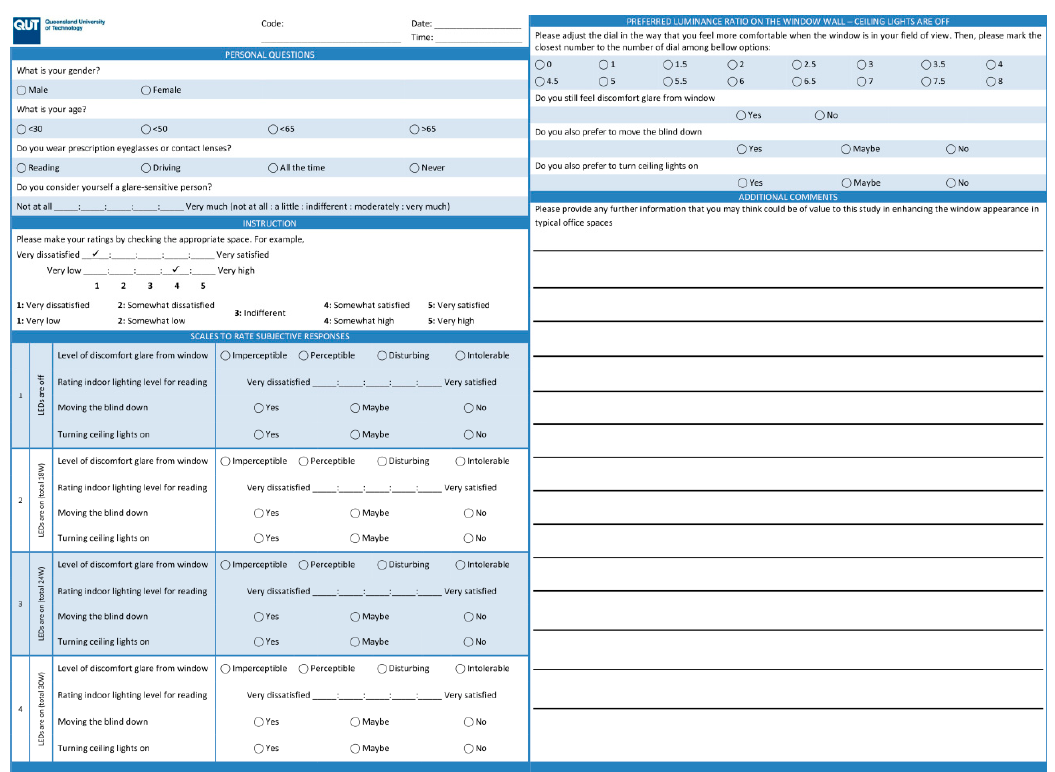
Figure 2. The questionnaire measuring participant characteristics, responses to lighting conditions and preferred luminance contrasts.